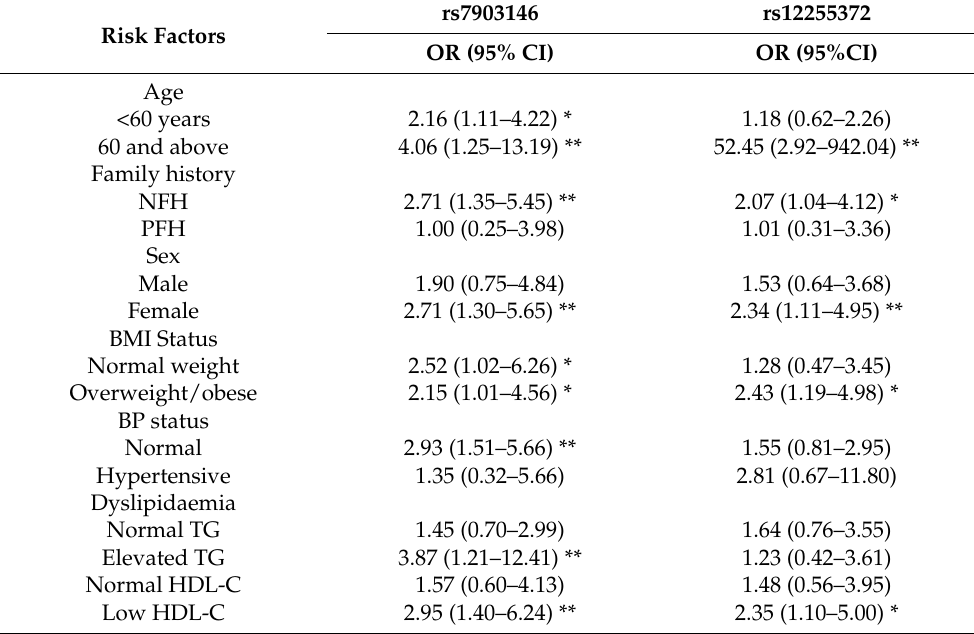
Table 4. Association between rs12255372 and rs7903146 polymorphisms and T2DM whiles keeping other metabolic risk factors as